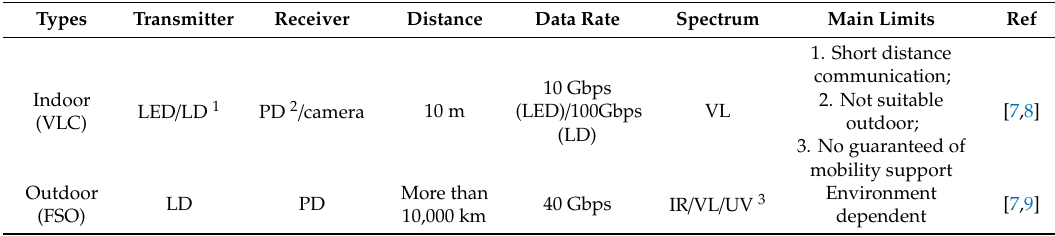
Table 1. Classification parameters of optical wireless communications